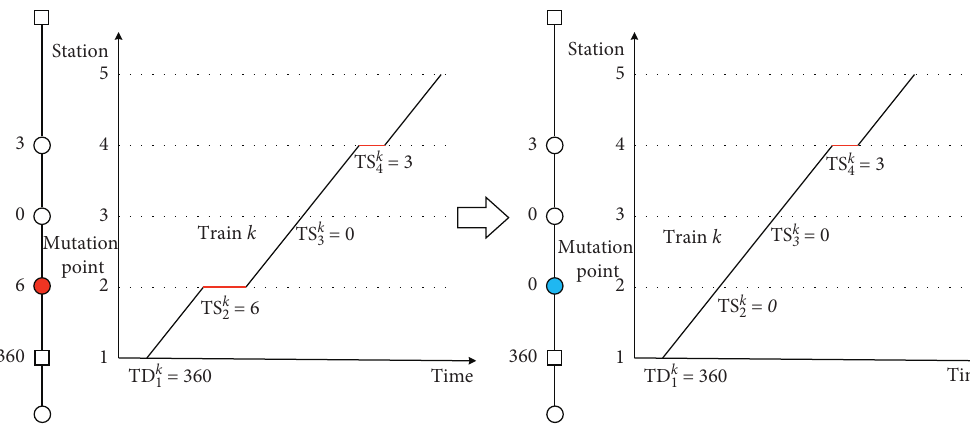
Figure 9: Mutation